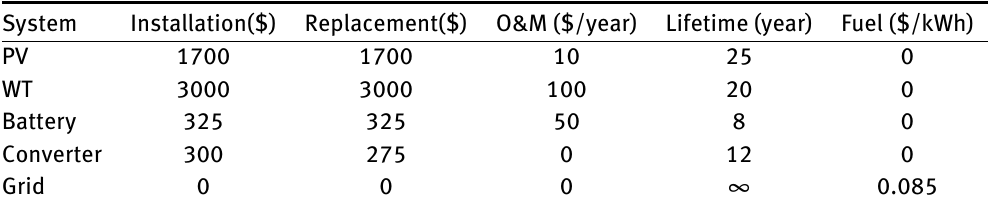
Table 2: economical cost of the grid-connected HRES